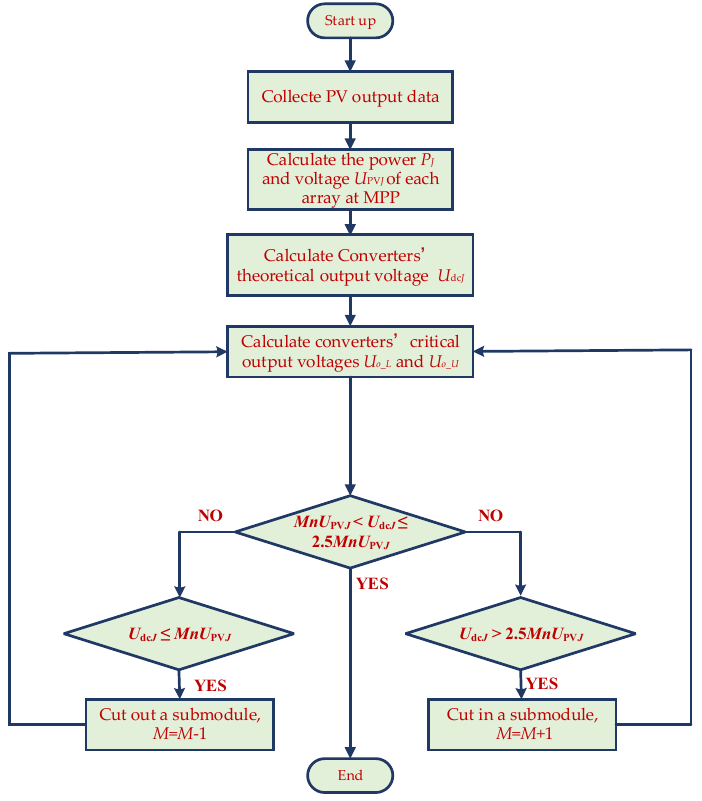
Figure 6. Flowchart of sub-modules’ control using cutting-in and cutting-out.